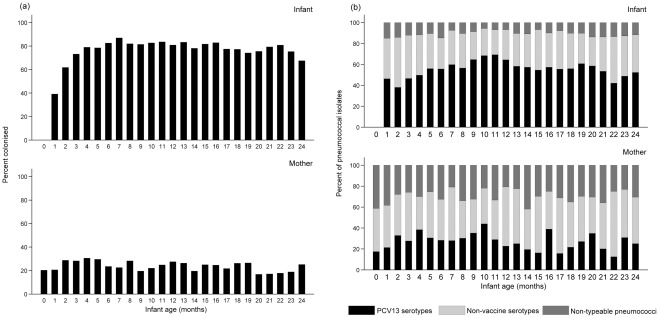
(a) Cross-sectional pneumococcal carriage prevalence and (b) pneumococcal isolates by serotype category (PCV13 serotype; non-vaccine serotype; non-typeable) in infants (top) and mothers (bottom) by month of infant age.